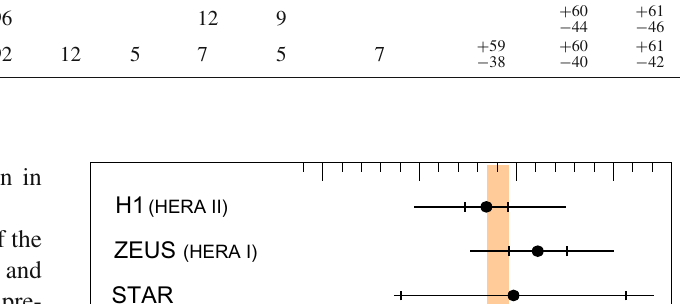
Table 4 Values of α s ( M Z ) for the simultaneous fit to the H1, ZEUS, STAR, CDF, D0, and CMS data using the common-type method for various PDF sets. The experimental, NP, PDFset, and scale uncertainties remain mostly unchanged under a change of the PDF set and are quoted only once for NNPDF3.0